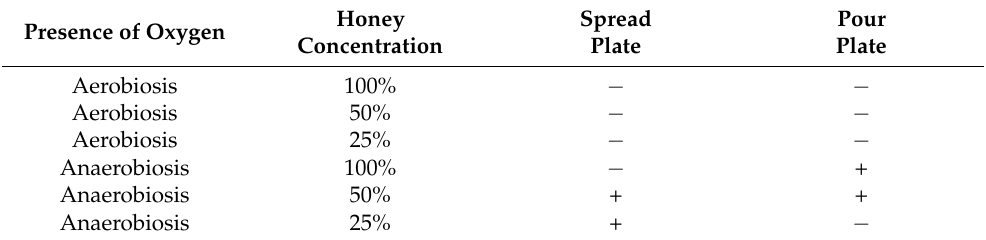
Table 1. Microbial growth of A. mellifera honey samples on MRS Agar for aerobic and anaerobic processes.